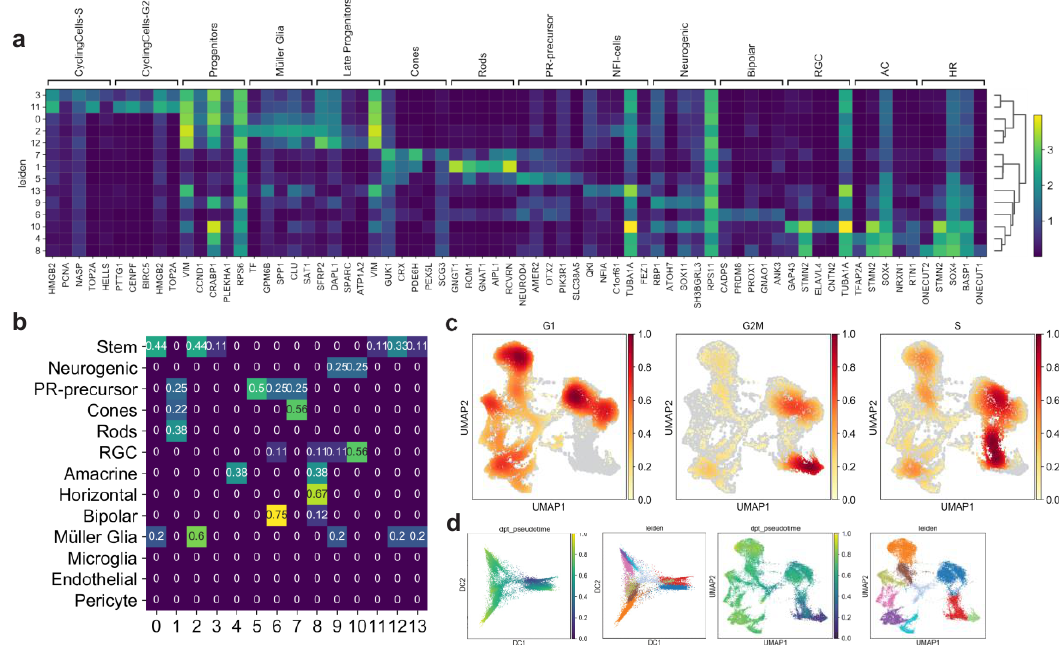
Figure A2. Retinal organoids scRNA-seq. ( a ) Matrix plot of the top five markers, calculated by t-test, for each Leiden cluster of hiPSC-derived retinal organoids. ( b ) Matrix showing the overlap score between the markers calculated for the Leiden clusters (0 – 13) and the known markers for retinal cell-types (Table A1). ( c ) hiPSC-derived retinal organoid cells in two-dimensional UMAP, showing the cell-cycle score computed per cell. ( d ) Subset of neuronal cell-fate in hiPSC retinal organoids. Cells are plotted in two diffusion dimensions (DC) and UMAP to show the highest variation found in the transition from progenitor cells to retinal neurons.